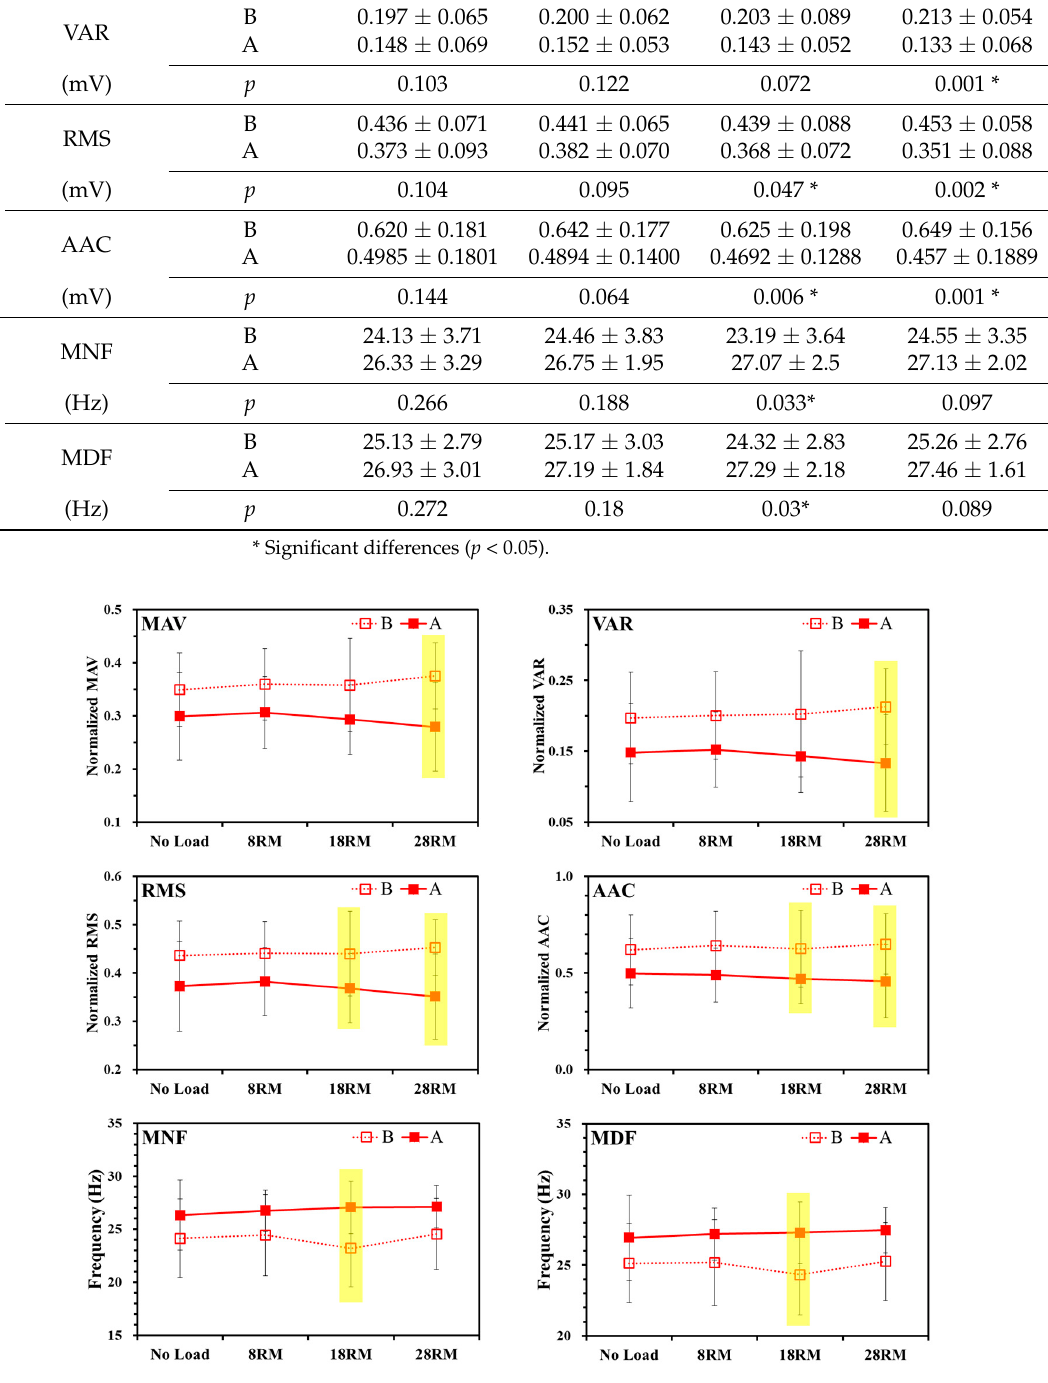
Figure 5. Average EMG measures for the bottom physical fitness group before (group B) and after (group A) the intensive exercise in graded force plate experiments.